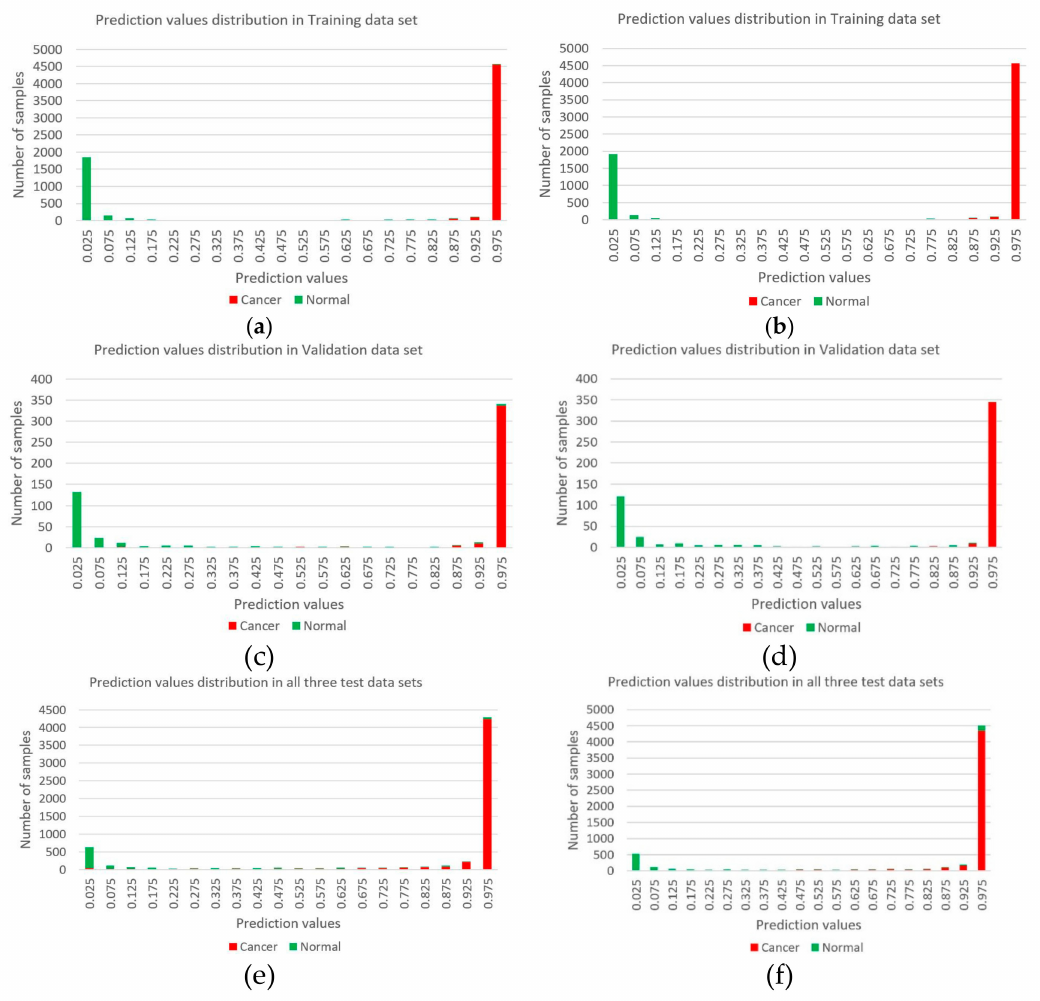
Figure 5. The distribution of prediction values in all samples. ( a , c , e ) come from 12 CpG markers and ( b , d , f ) come from 13 promoter markers. Red indicates the status of the sample is cancer, and green indicates the status of the sample is